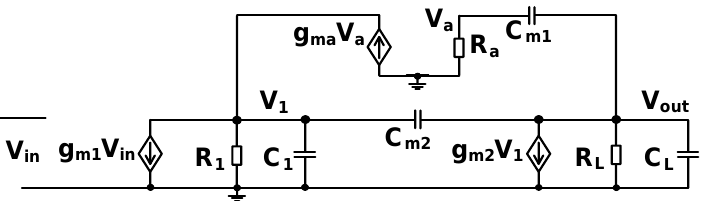
Figure 9 shows the equivalent small-signal model of the amplifier. Because the open-